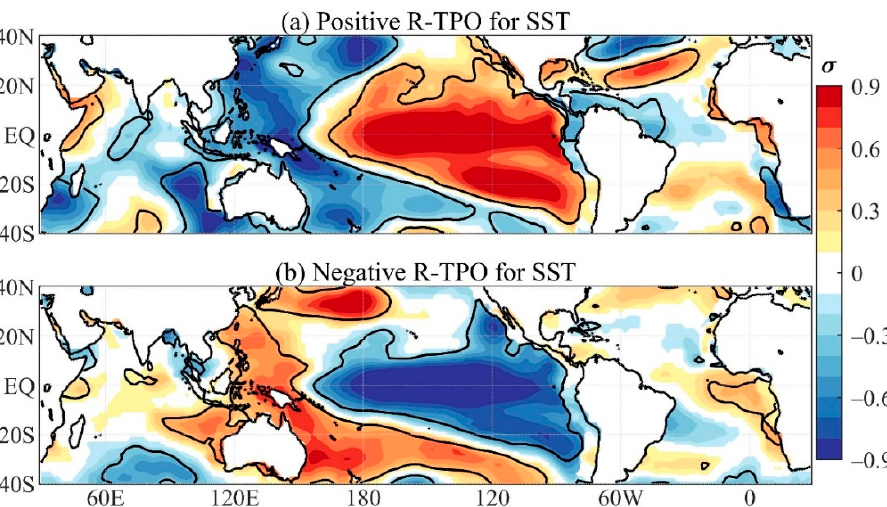
Figure 3. Composite of the residual SST anomalies during austral spring for the: ( a ) positive R-TPO; and ( b ) negative R-TPO. In this Figure, residual means without the IOD effects. Continuous contours encompass significant values at a 95% confidence level using the Student’s t -test.